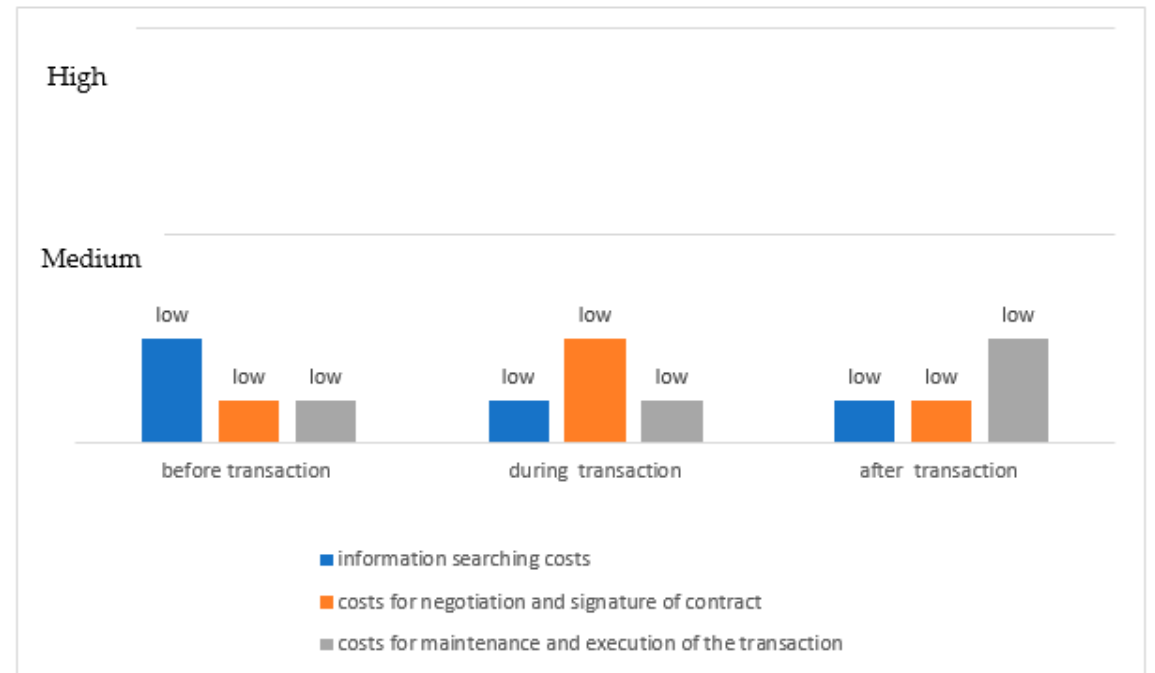
Figure 1. Transaction costs at different stages in the “land coupon” model.